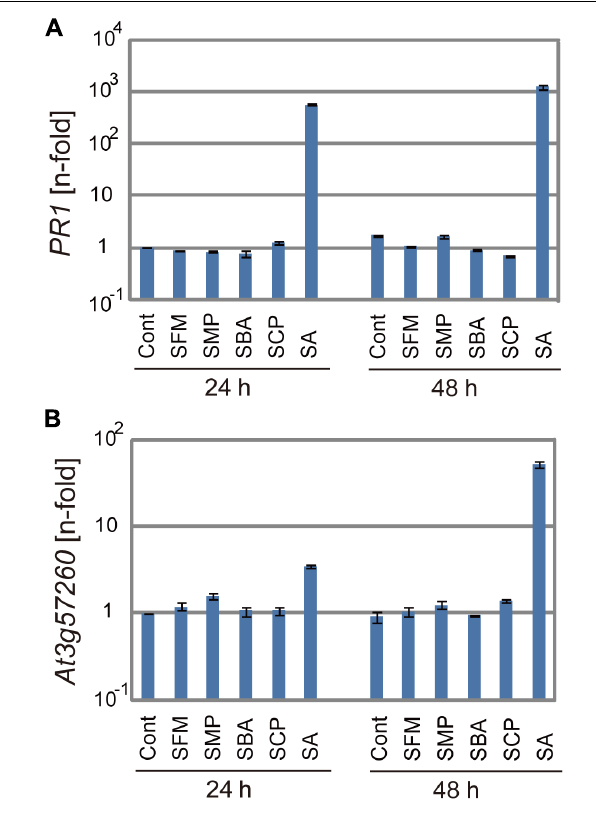
FIGURE 5 |The expression of defense genes after application of the sulfonamides. The mRNA levels of PR1 (A) and At3g57260 (B) were determined by qRT-PCR with cDNA prepared from 10-day-old seedlings soaked for 24 or 48 h in liquid media containing 100 μ M of each chemical. The expression values of the individual genes were normalized using Actin2 as an internal standard.The data represent relative values with respect to the control.The bars represent the mean ± SE values of three independent replicates.